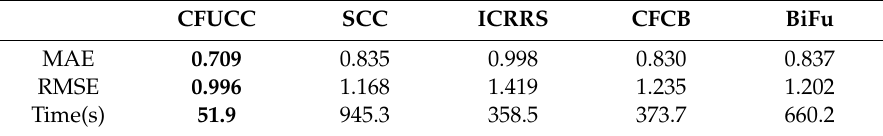
Table 4. Performance comparisons among di ff erent methods for Experiment 1.